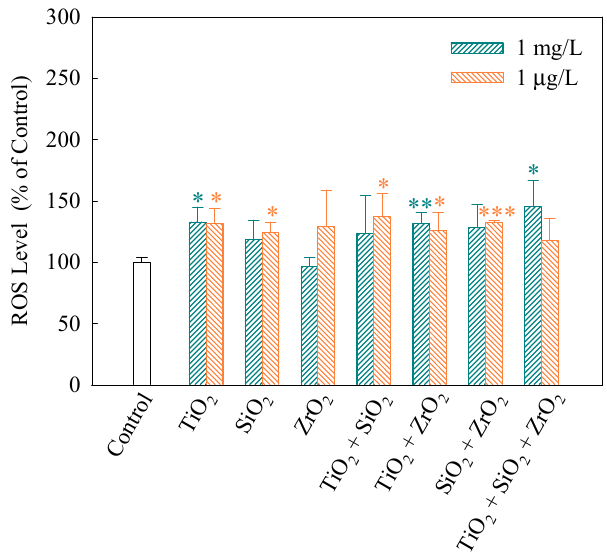
Figure 3. Relative levels of reactive oxygen species (ROS) detected using 2 ′ ,7 ′ -dichlorodihydrofluorescein diacetate (DCFH-DA) staining in S. obliquus exposed to 1 mg/L and 1 µ g/L of NPs alone, 1 mg/L and 1 µ g/L of single NPs in binary combination and 1 mg/L and 1 μ g/L of single NPs in ternary combination. Statistical significance versus control group: * p < 0.05, ** p < 0.01 and *** p < 0.001.